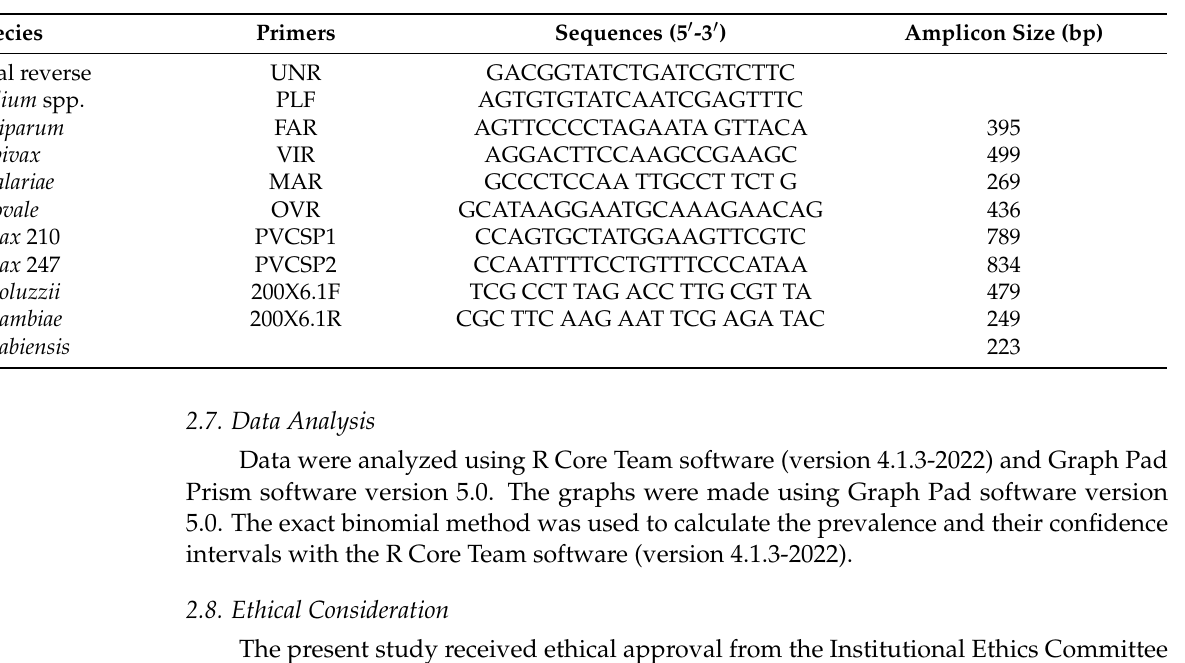
Table 1. Primers used for the detection and identification of Plasmodium and An. gambiae complex